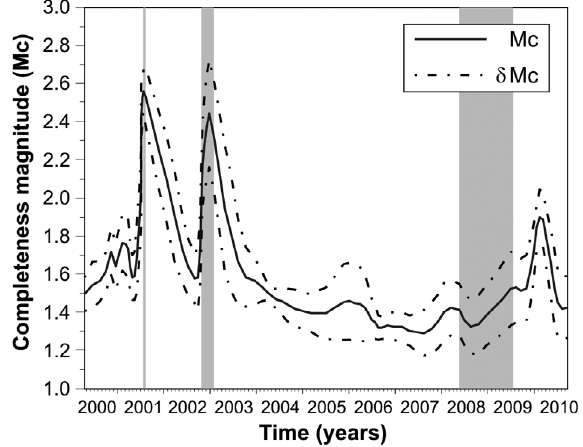
Figure 11. Temporal trend of completeness magnitude (Mc) during the 2000-2010 time span. The dashed line marks the standard deviation value of Mc. The periods marked in gray indicate the main flank